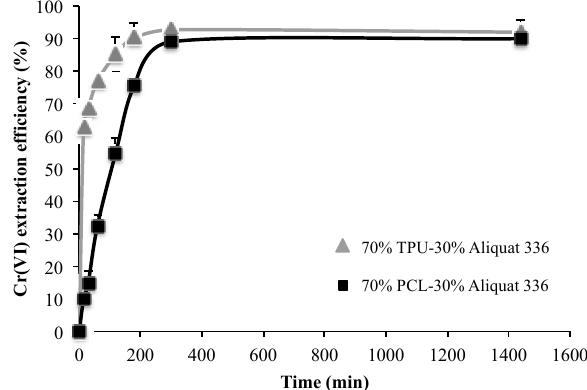
Figure 4. Transient Cr(VI) extraction at pH 4 using two different PIM compositions (n = 2).